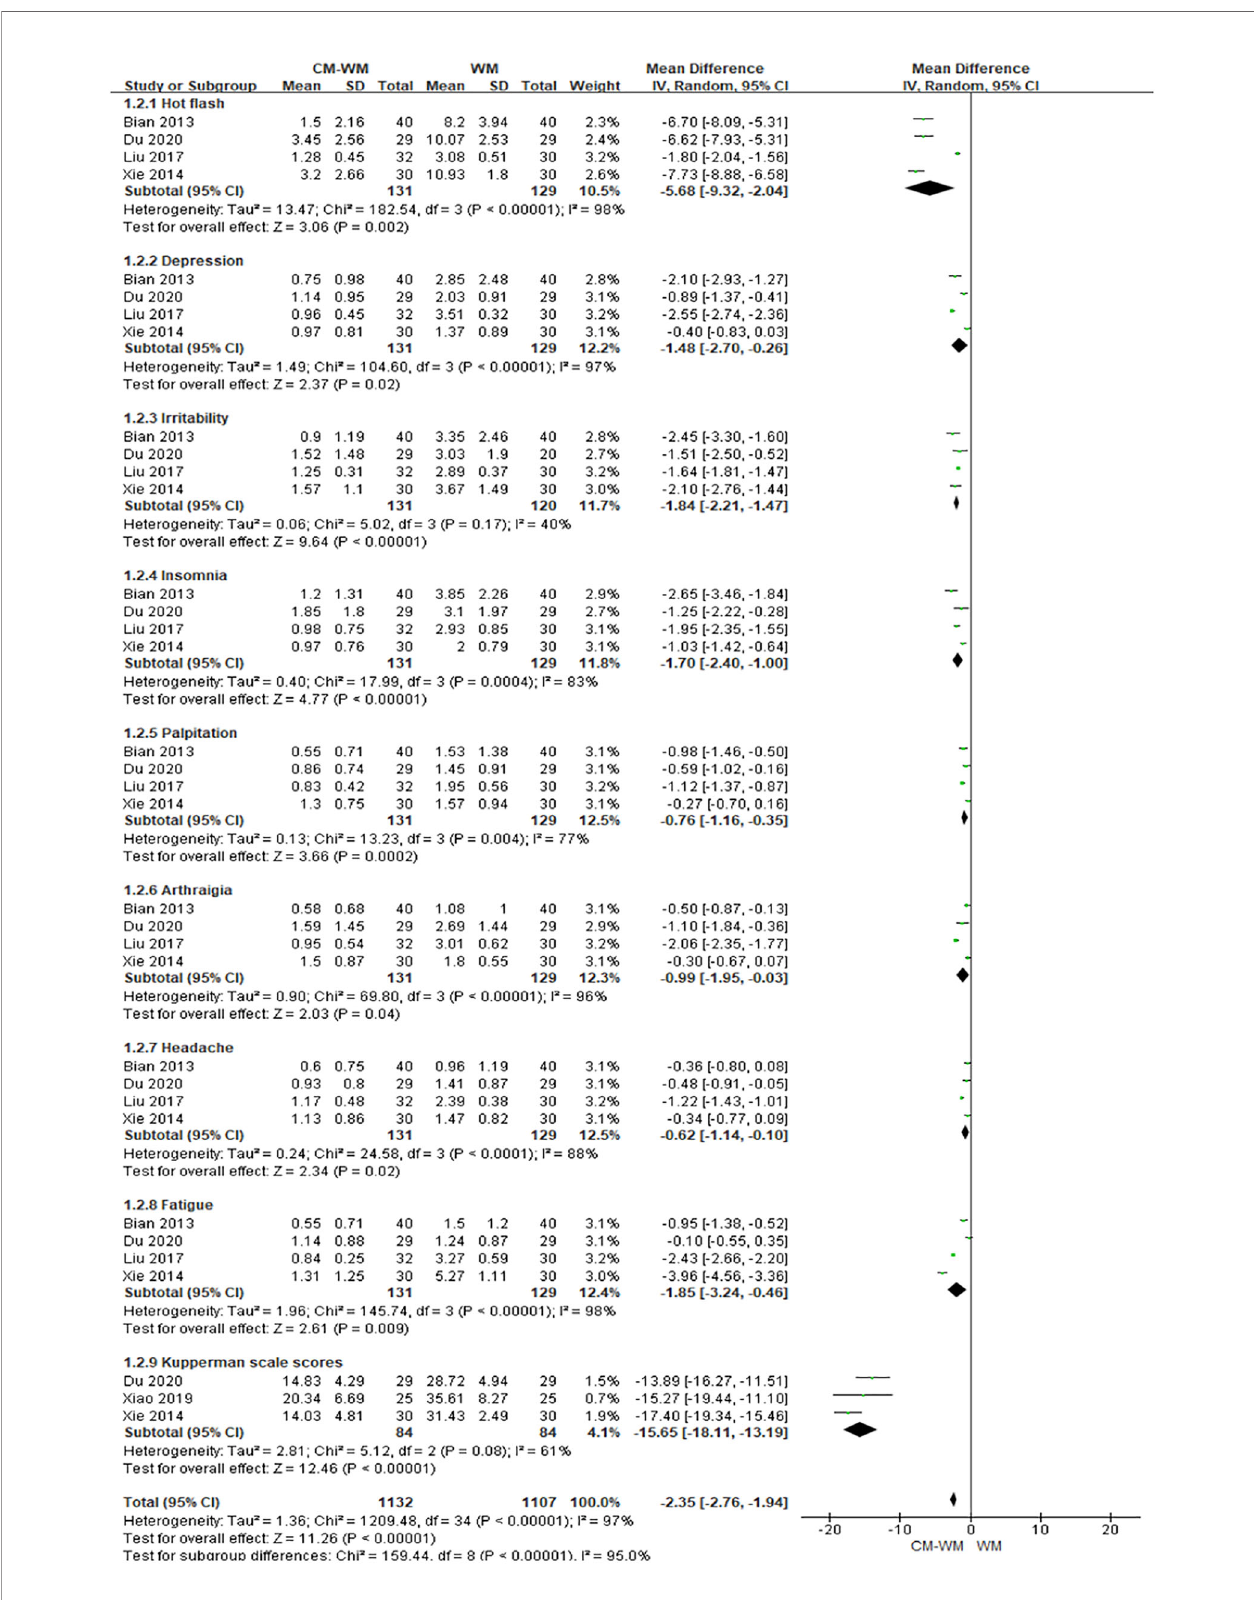
FIGURE 3 | Meta-analyses on Kupperman